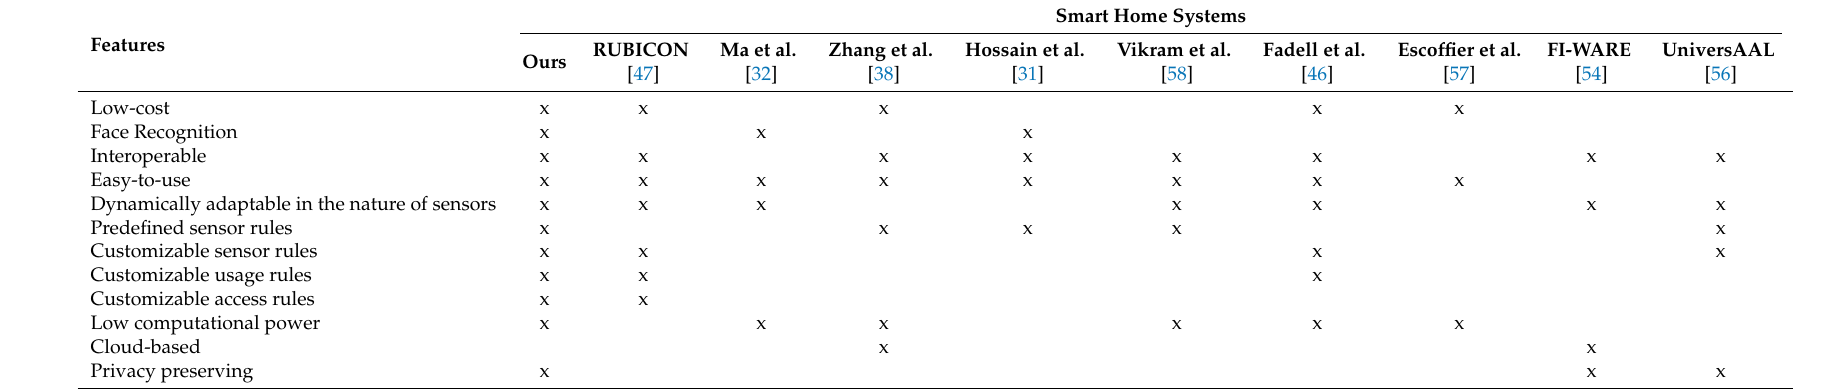
Table 1. Summary of the features of the of some Smart Home Systems described in the